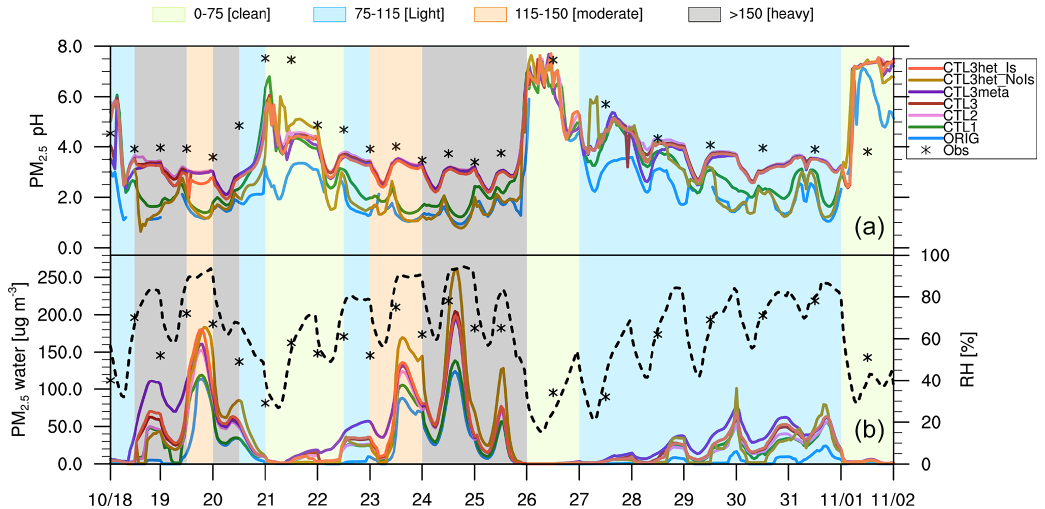
Figure 4. Time series of (top panel) surface PM 2 . 5 pH, and (bottom panel) PM 2 . 5 water contents (µgm − 3 ) (left y axis) predicted by all WRF-Chem scenarios at the Beijing site during the study period of 15 October–2 November 2014, and relative humidity (RH, %) (right y axis, dashed black line) are derived from the ORIG scenario. ISORROPIA II-calculated pH values constrained by observations as well as the observed RH are shown as black star markers, with each value corresponding to a PM 2 . 5 sample (12h or 24h). Shaded areas represent four different pollution levels (green-clean; blue-light; orange-moderate;